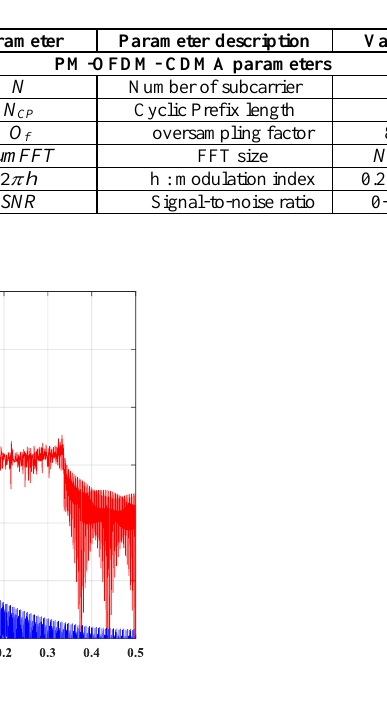
Table 1. Simulation parameters.